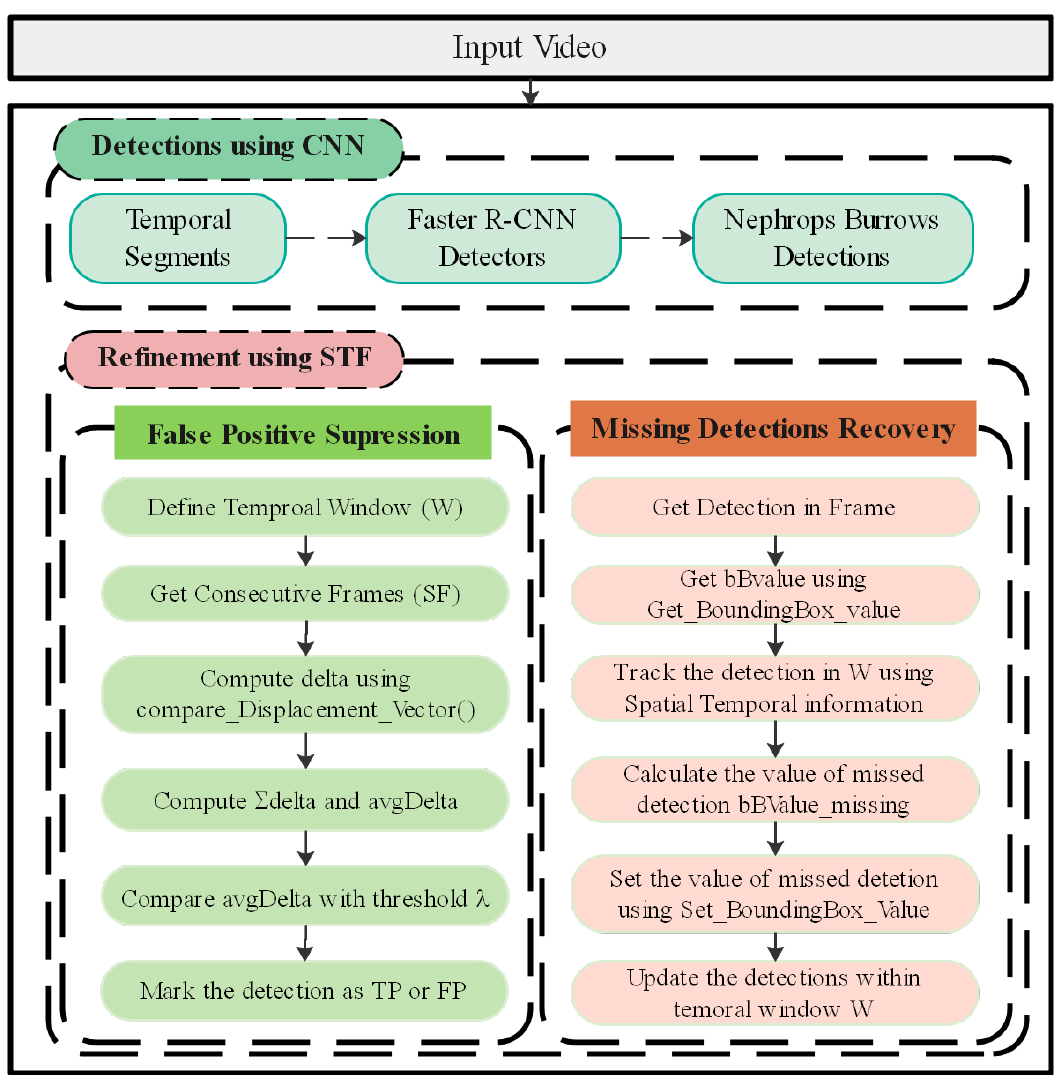
Figure 7. Detection refinement algorithm.